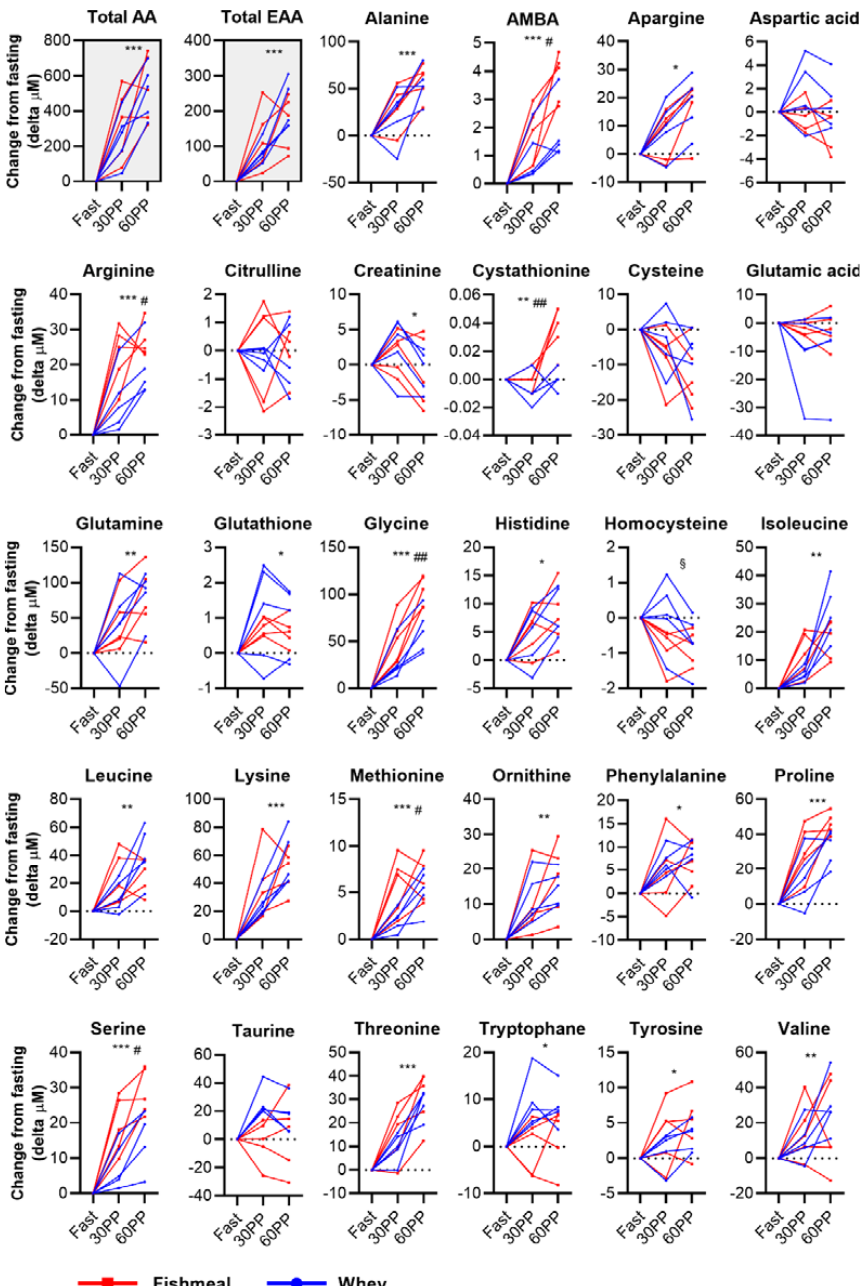
Figure 2. Changes in the serum amino acid concentration after the intake of fishmeal or whey. The concentration of 28 amino acids and amino acid derivatives was measured in serum with HPLC- MS/MS before (Fast), and 30 min postprandial (30PP) and 60 min postprandial (60PP), after the intake of fishmeal or whey. The total amino acids (Total AA) and total essential amino acids (Total EAA) were calculated as the molar sum of the individual amino acids measured in serum. Changes in the serum amino acids are expressed as change from fasting (delta µ M). Red lines indicate each participant’s response to the intake of fishmeal, while blue lines indicate the response to whey. The overall difference between time points and protein sources was tested with a repeated measures, two-way ANOVA. * p < 0.05,** p < 0.01 and *** p < 0.001: overall difference between time points. # p < 0.05 and ## p < 0.01: overall difference between fishmeal and whey. § p < 0.05: interaction effect (time and protein